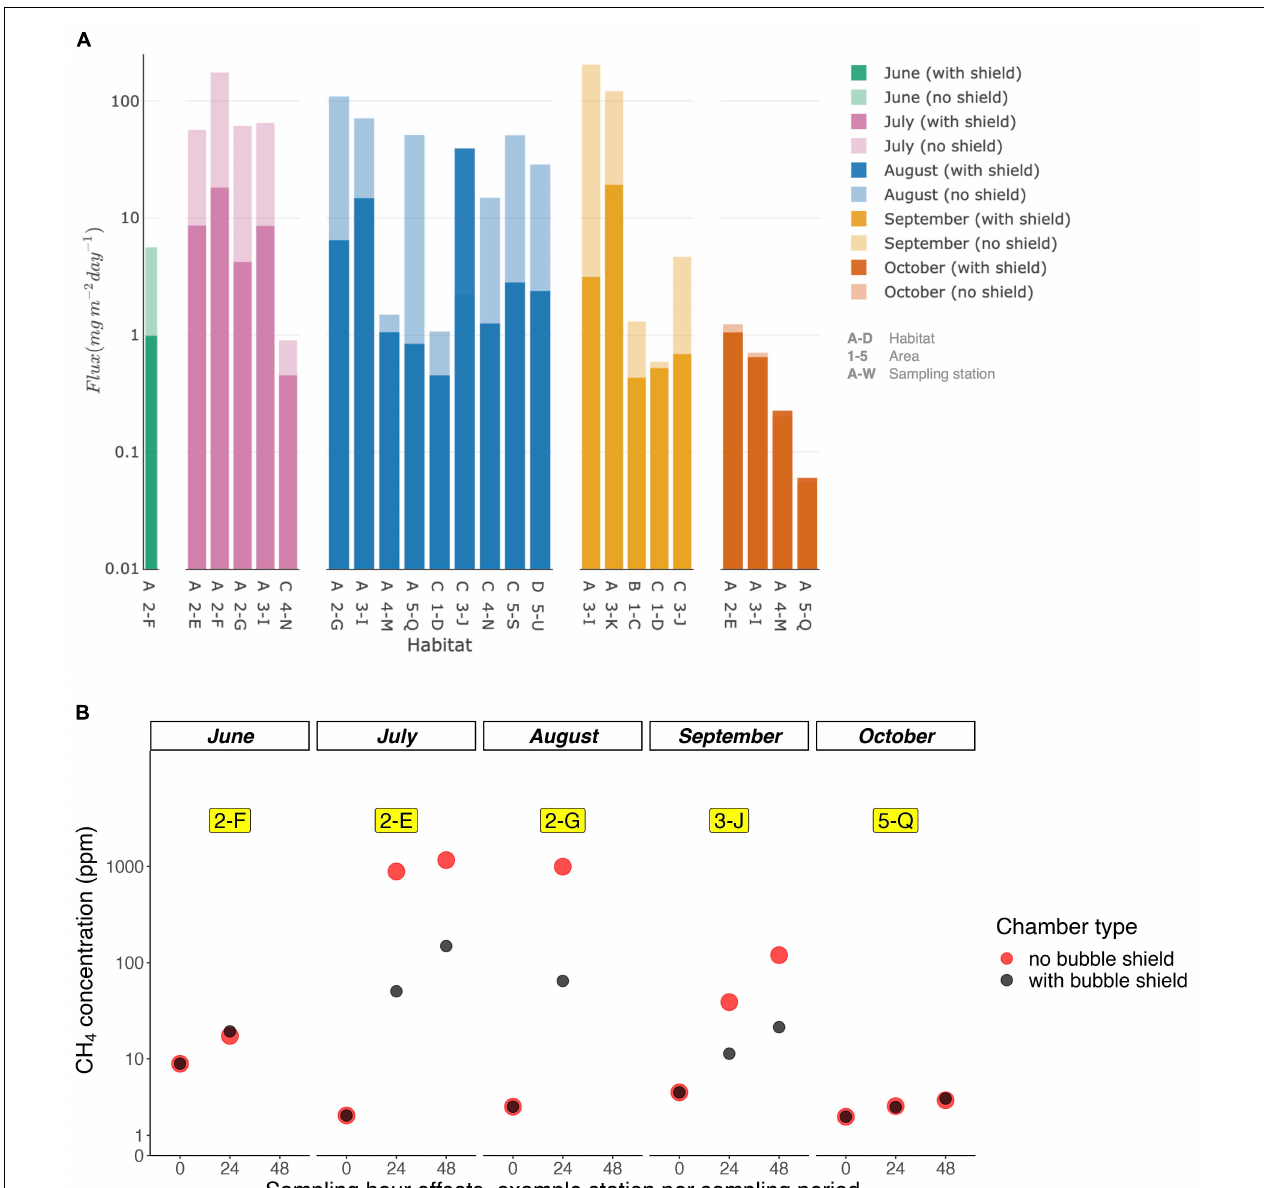
FIGURE 6 | Comparison between CH 4 flux with and without bubble shield for different habitats (A) and during the different sampling periods (B)